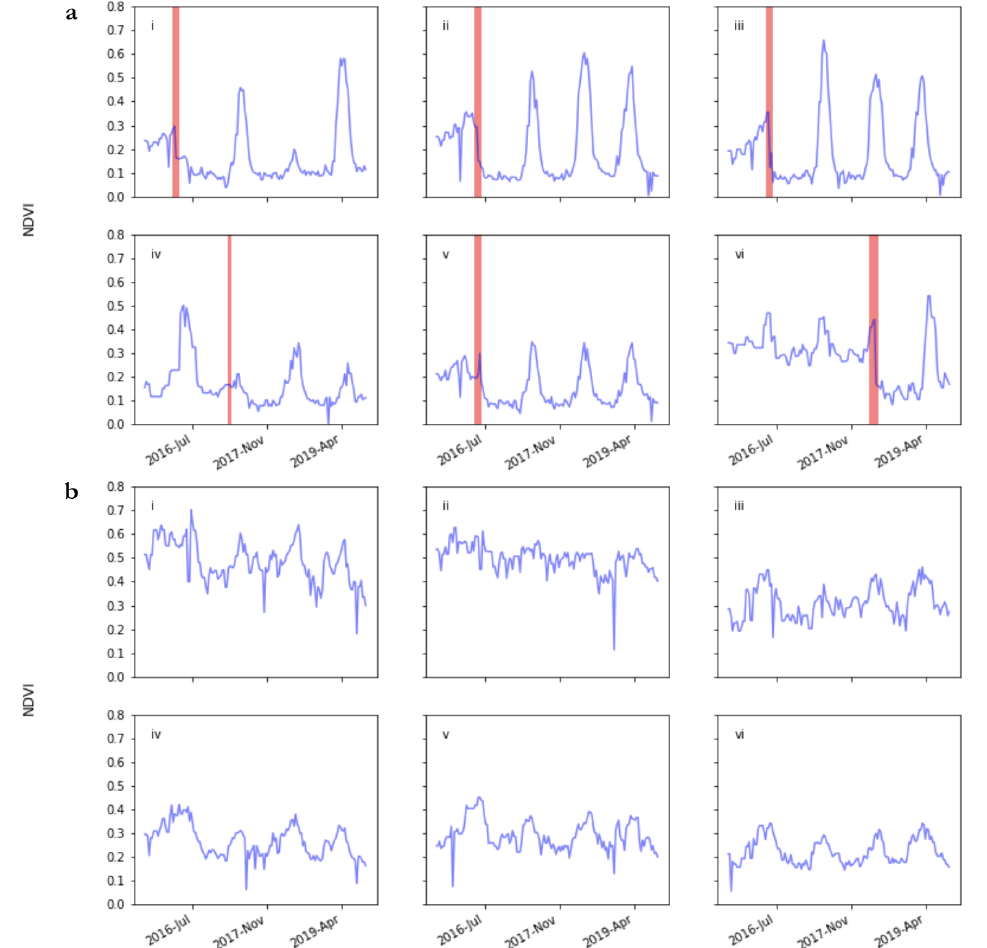
Figure 3. Observed NDVI time series for the full period covered by training and validation data for randomly selected pixels from across the study region. Vegetation in all time series begins as natural Renosterveld. In panel ( a ), land cover change events occur in the period highlighted in red, and thereafter the land cover is non-natural. These time series show the fall in minimum NDVI that occurs when Renosterveld is converted to cropland (iv) and increase in NDVI seasonality—with NDVI exceeding 0.5 in winter but falling to around 0.1 in summer (ii, iii). However, at some sites in some years, NDVI fails to reach expected highs in croplands (i). NDVI can also be higher in natural vegetation than the winter peak in croplands in some years (iv). In ( b ), vegetation remains natural for the entire time series. The higher natural variability in NDVI seasonality is evident in (i) and (v), with some sites having little to no NDVI seasonality (ii). Average NDVI in sites with natural vegetation can vary from 0.5 to 0.2, and large drops in NDVI unrelated to vegetation change can also occur (i). These examples serve to illustrate the complex natural variability within natural vegetation and the challenge of extracting reliable identifiers of land cover change from satellite image time